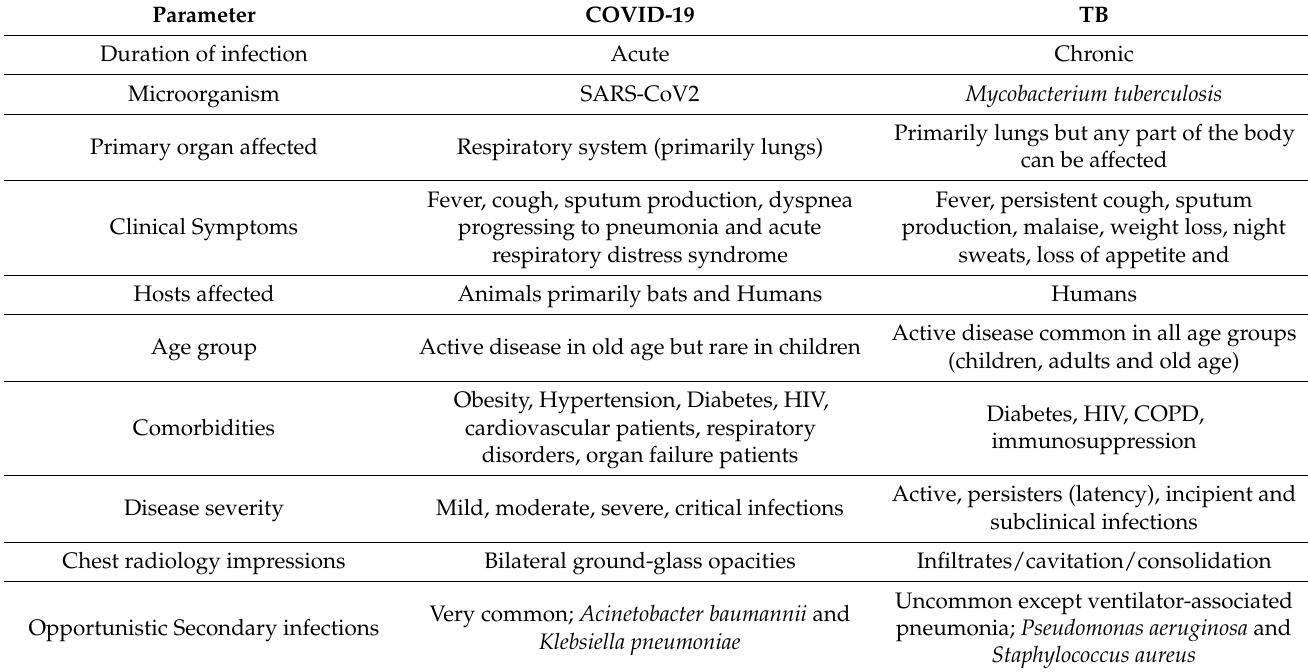
Table 4. Clinical parameters of COVID-19 and tuberculosis